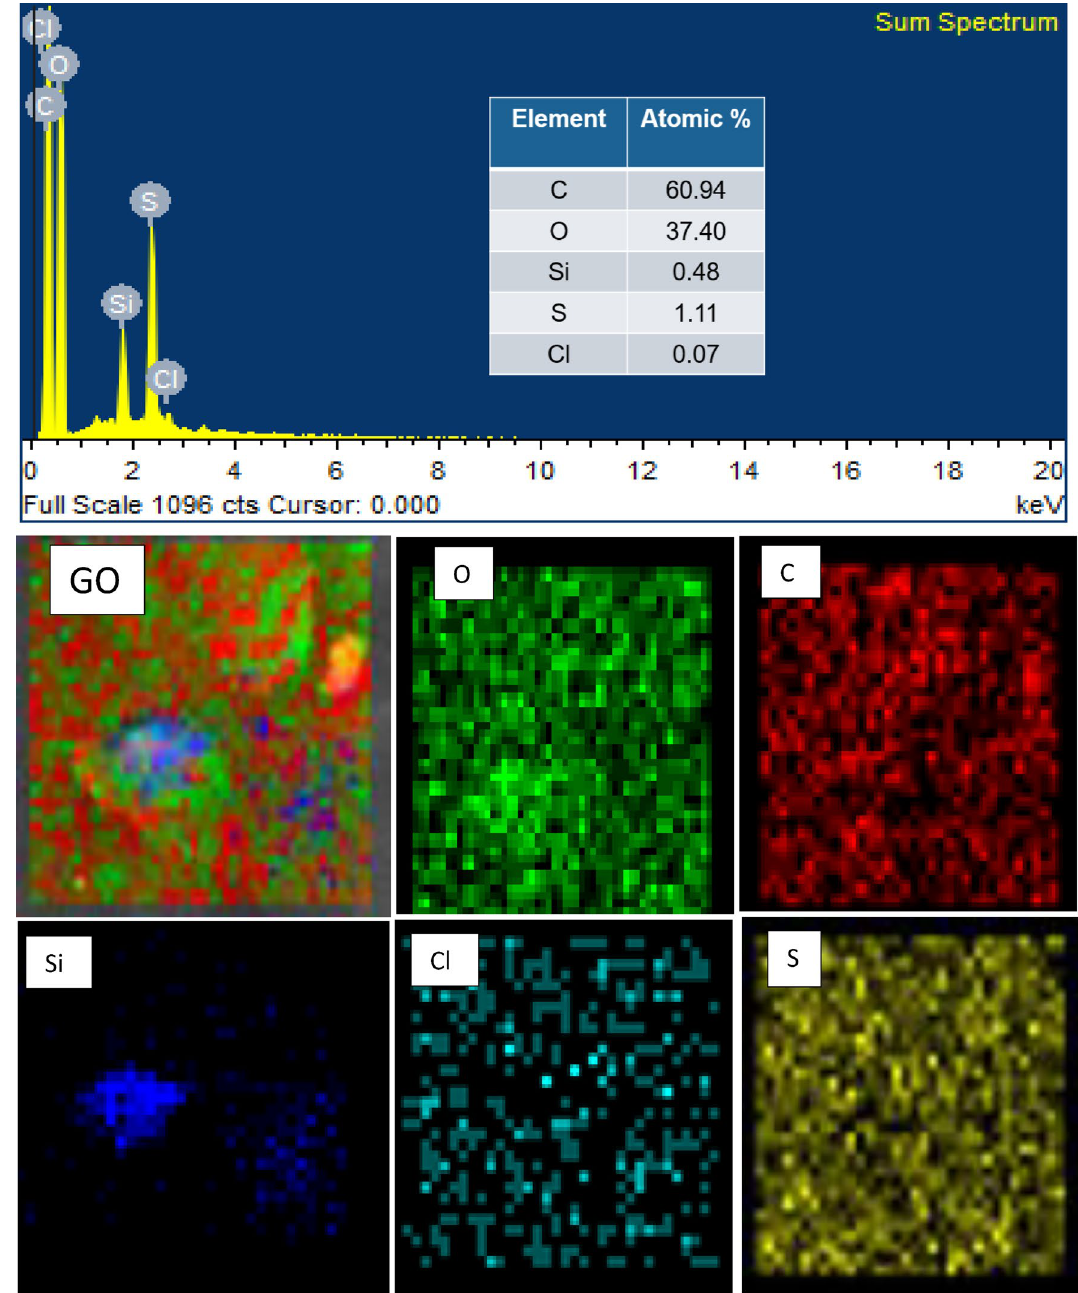
Figure 4. EDX spectra of pure graphene oxide nanosheets. Elemental mapping of pure GO sample reflects the presence of different constituents in GO as O (oxygen), C (Carbon), Si (Silicon), Cl (Chlorine) and S